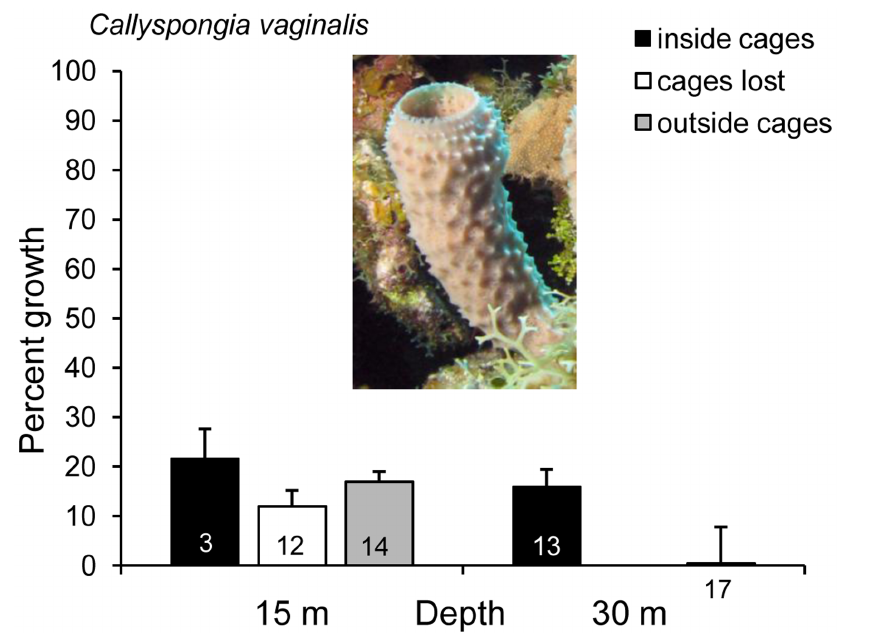
Figure 2. Percentage growth of the gray tube sponge Callyspongiavaginalis (change in wet mass) 358 days after placement inside and outside of predator-excluding cages at 15 m and 30 m depth on Conch Reef, Florida. Winter storms removed all but 3 cages at the 15 m site; growth of sponges that had been caged by lost cages is shown separately. Surviving number of 20 replicates is shown for each bar, error bars are standard error. Statistical analyses were performed on transformed data (growth index).